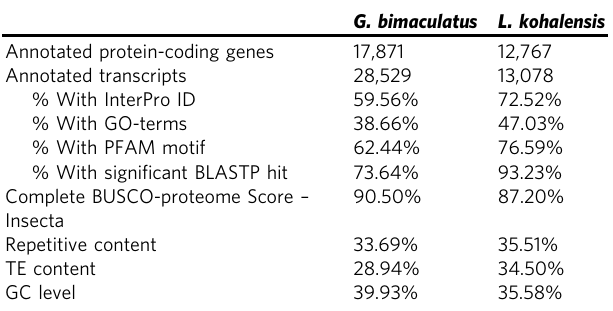
Table 2 Genome annotation summary for the crickets G. bimaculatus and L. kohalensis .